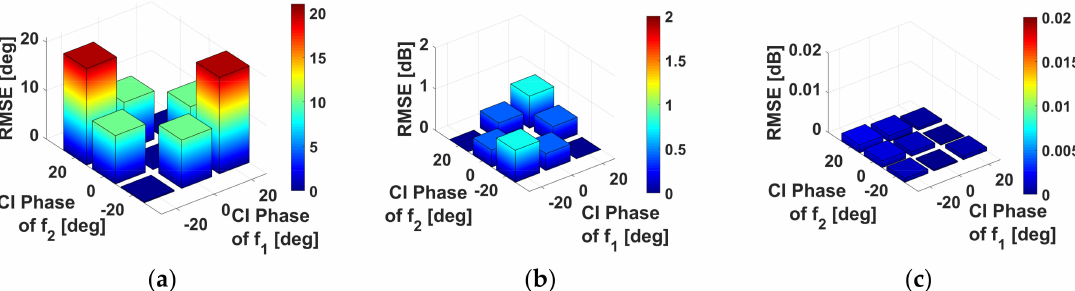
Figure 4. RMSE of channel imbalance estimation for imbalance phase variability, using simulation data obtained by ( a ) Van Zyl method, ( b ) the Quegan method, and ( c ) the Villa method. Note that the vertical axes have different